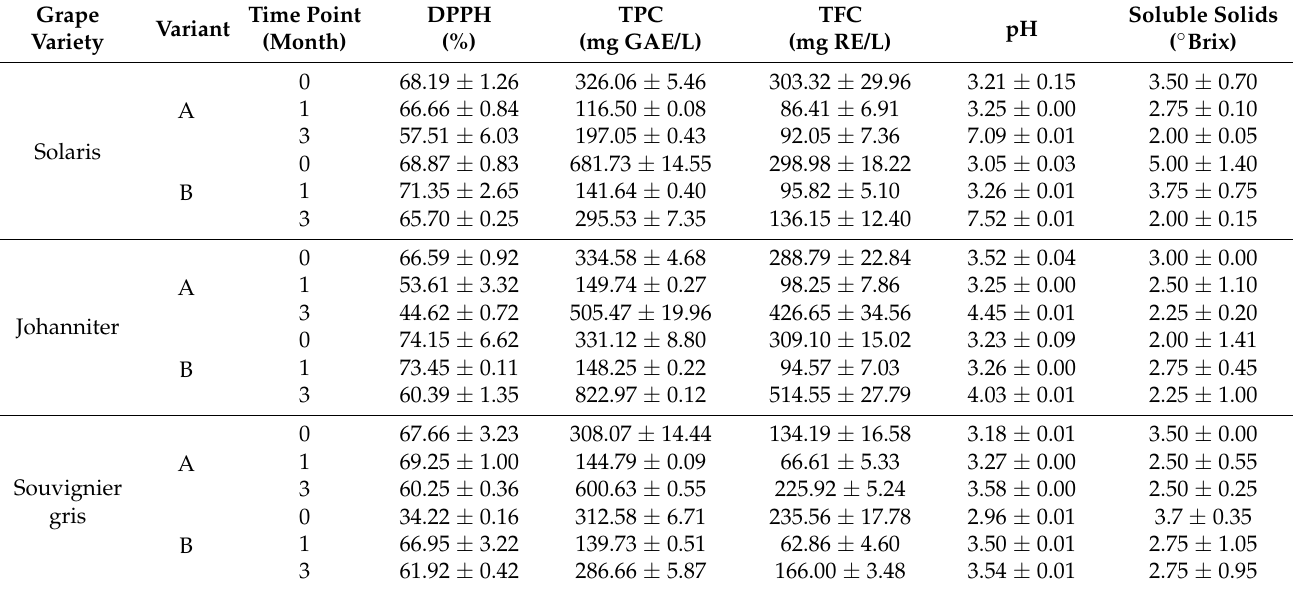
Table 5. DPPH (Antioxidant potential), TPC (Total Phenolic Content), TFC (Total Flavonoid Content), pH and soluble solids content in the analysed vinegar samples during storage at room temperature. The results are presented as mean ± standard deviation of 9